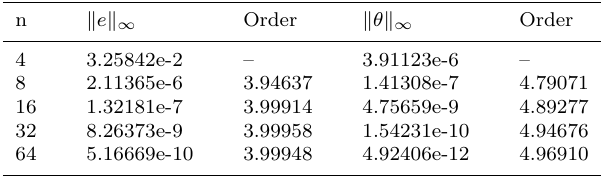
Table 1. Numerical results for example 1.